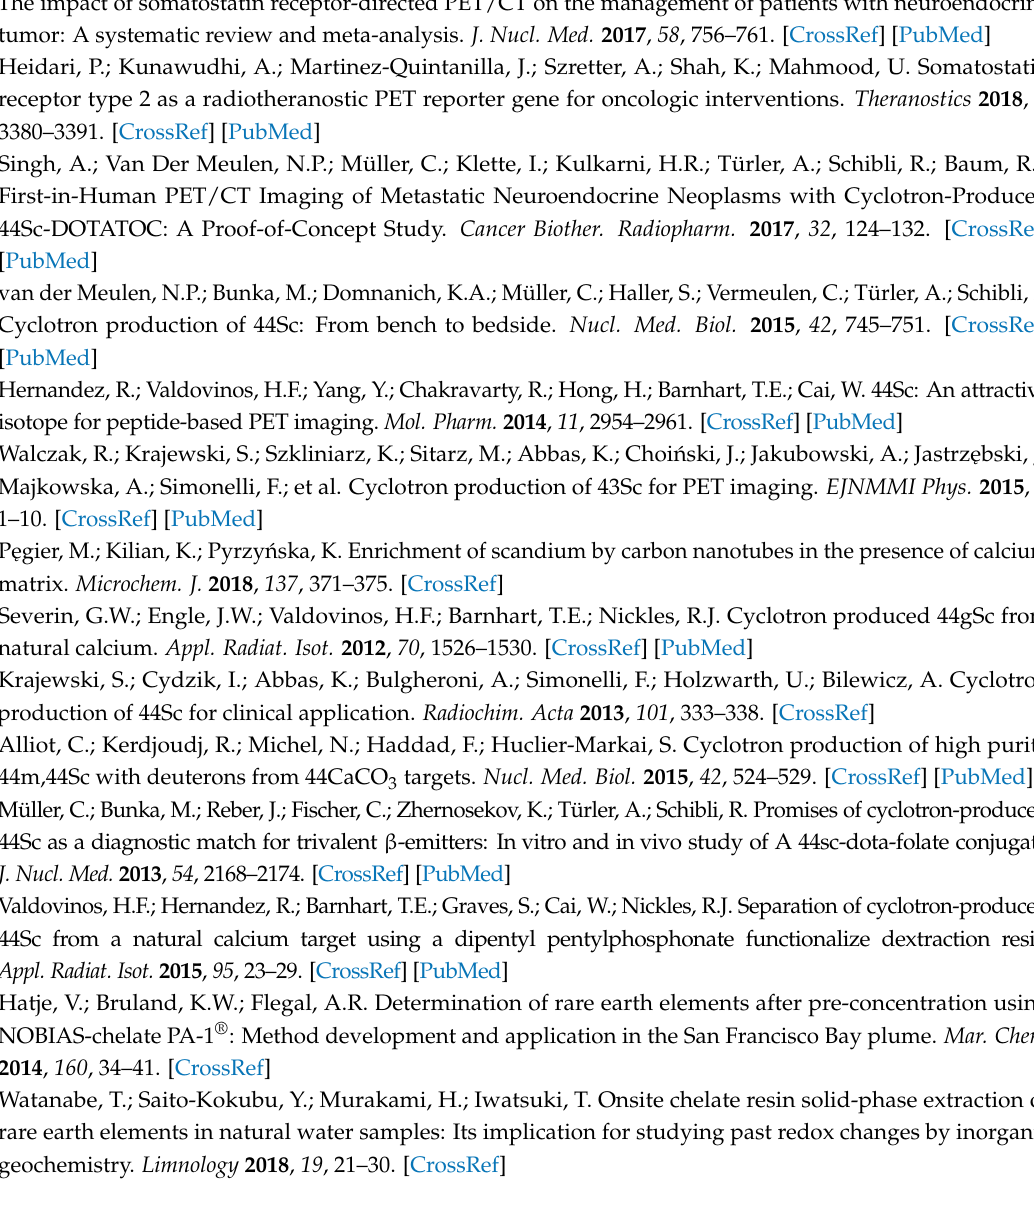
Supplementary Materials: The following are available online. Figure S1: pH dependence of Ca concentration in 44 Sc solution after separation, Figure S2: Elution profiles of Nobias column and 0.22 µ m filter, Figure S3: Thin-layer chromatograms of 44 Sc-DOTATATE, 44 Sc and resolution test for the mixture of 44 Sc and 44 Sc-DOTATATE, Figure S4: HPLC Resolution test for 44 Sc and 44 Sc-DOTATATE, Figure S5: Stability test for 44 Sc-DOTATATE within 36 h after end of synthesis (EOS), Figure S6: γ -spectra of produced 44 Sc, Table S1: 44 Sc labeling yields for DOTATATE at different ligand